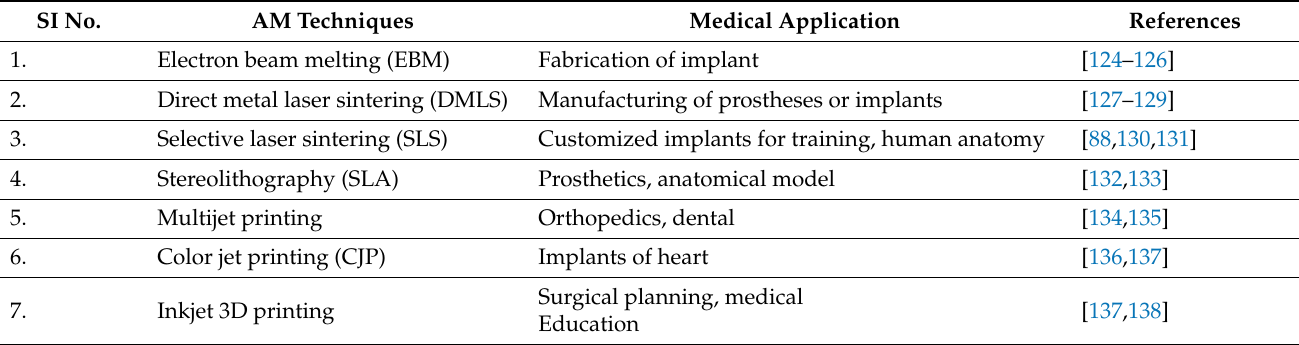
Table 1. AM technologies and their medical